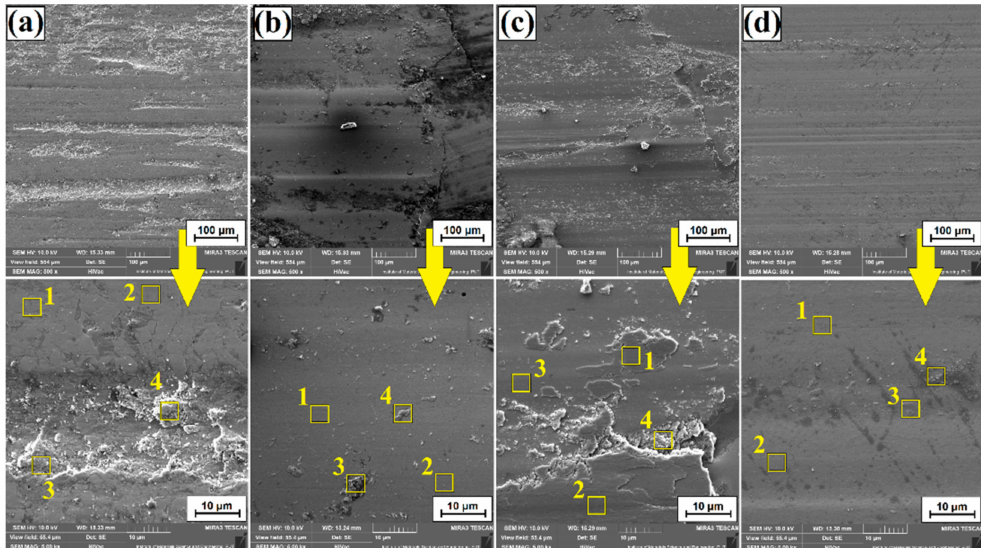
Figure 12. Surface condition after wear resistance tests: ( a ) diffusion borochromized layer, ( b ) B-Cr coatings produced using 600 W, ( c ) B-Cr coatings produced using 900 W, and ( d ) B-Cr coatings produced using 1200 W. Table 4. Chemical composition (EDS) results after wear resistance tests.